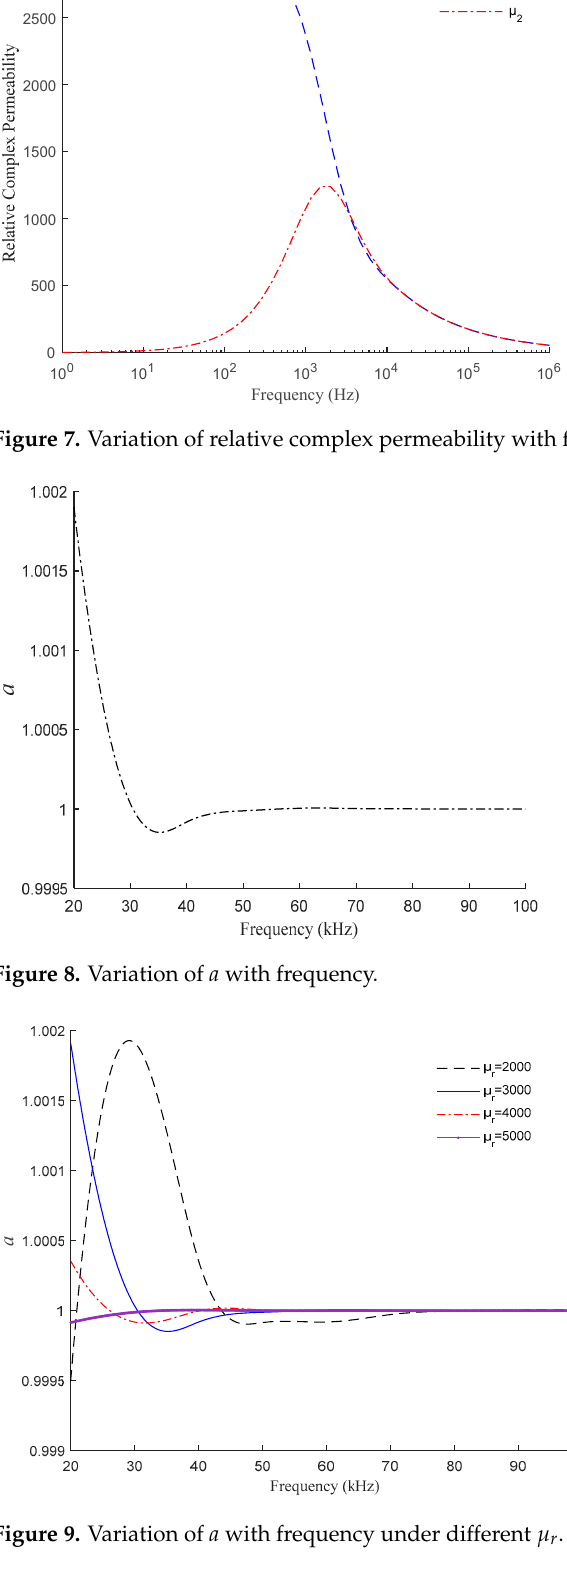
Figure 7. Variation of relative complex permeability with frequency.